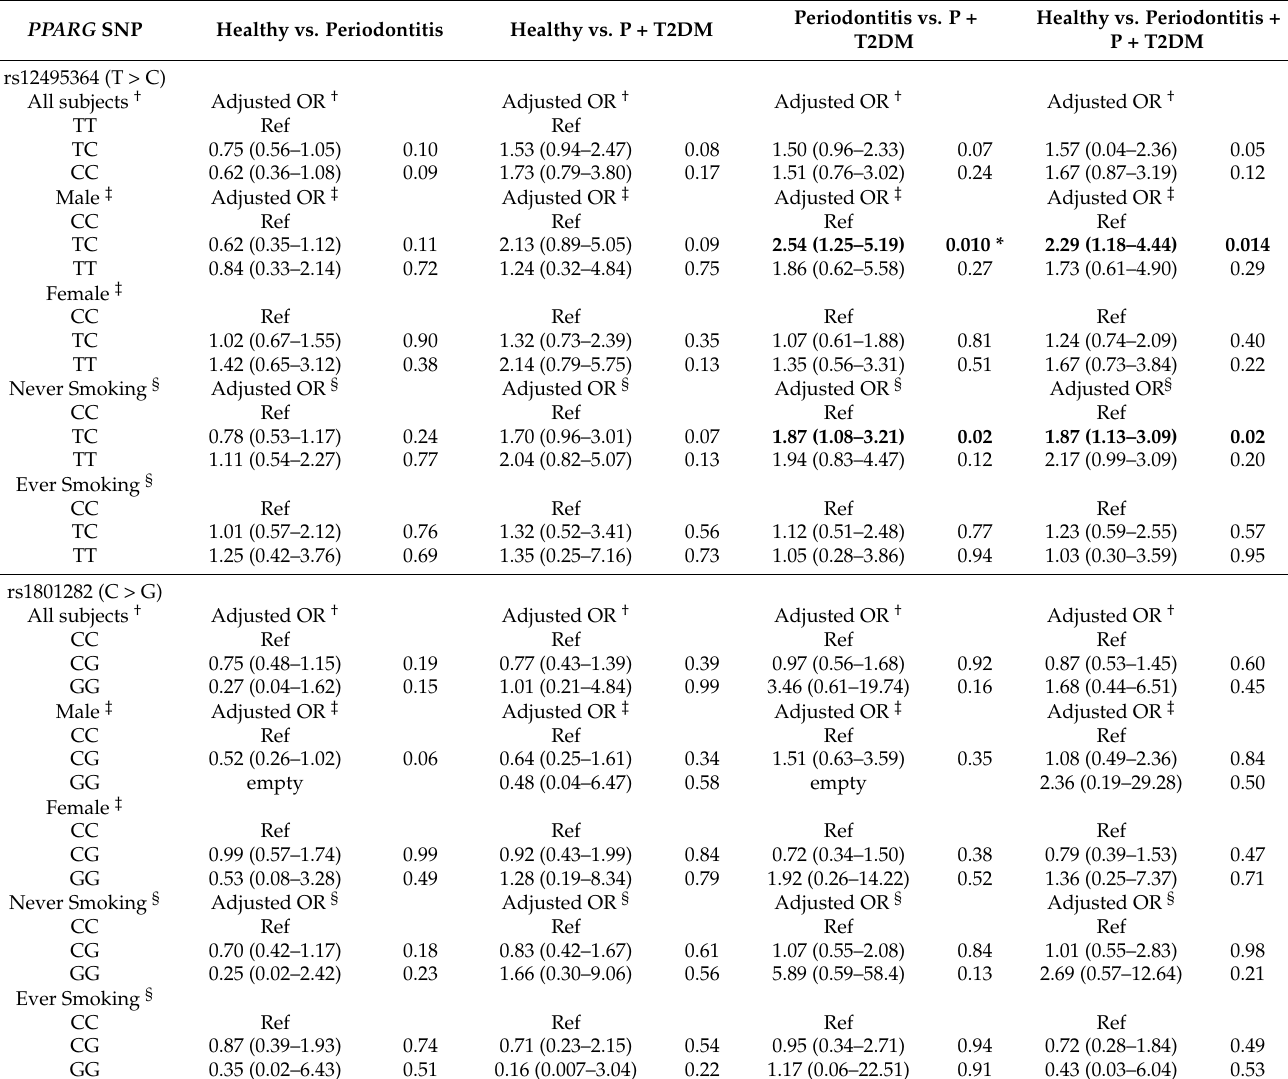
Table 2. Multiple logistic regressions adjusted for age, sex, and smoking status and stratified by sex and smoking